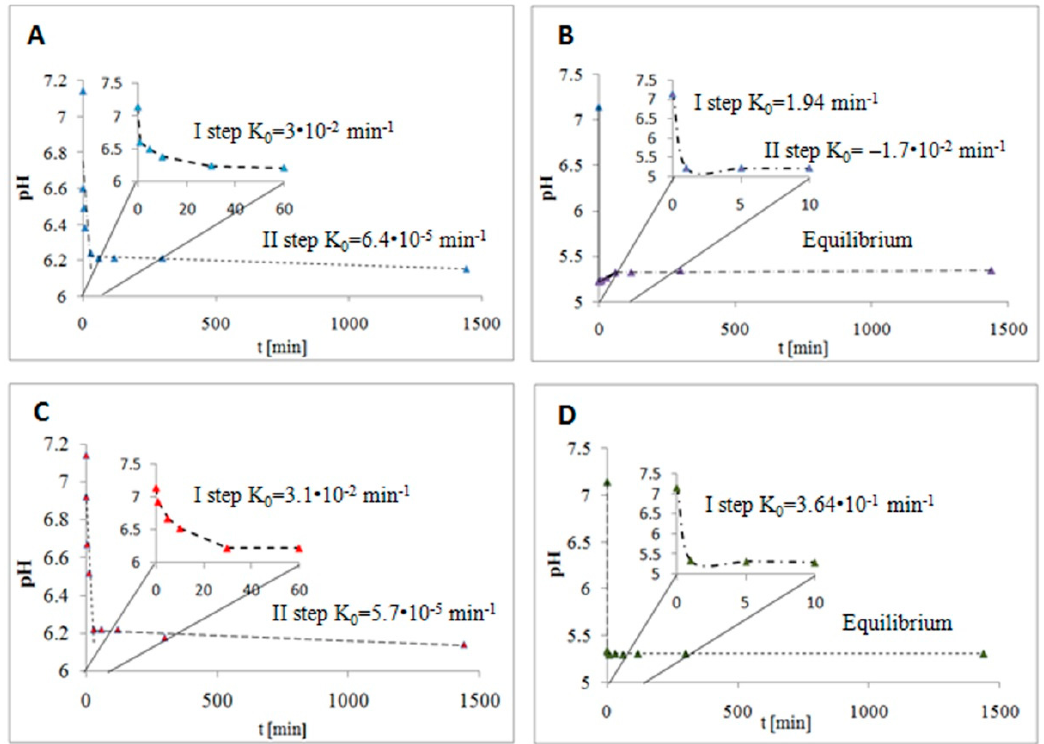
Figure 2. Zero-order kinetic model of protein–cyclitol interactions (at the 1:10 molar ratio): ( A ) BSA–adonitol; ( B ) BSA–D-( – )-quinic acid; ( C ) BSA–D-sorbitol; ( D ) BSA–shikimic